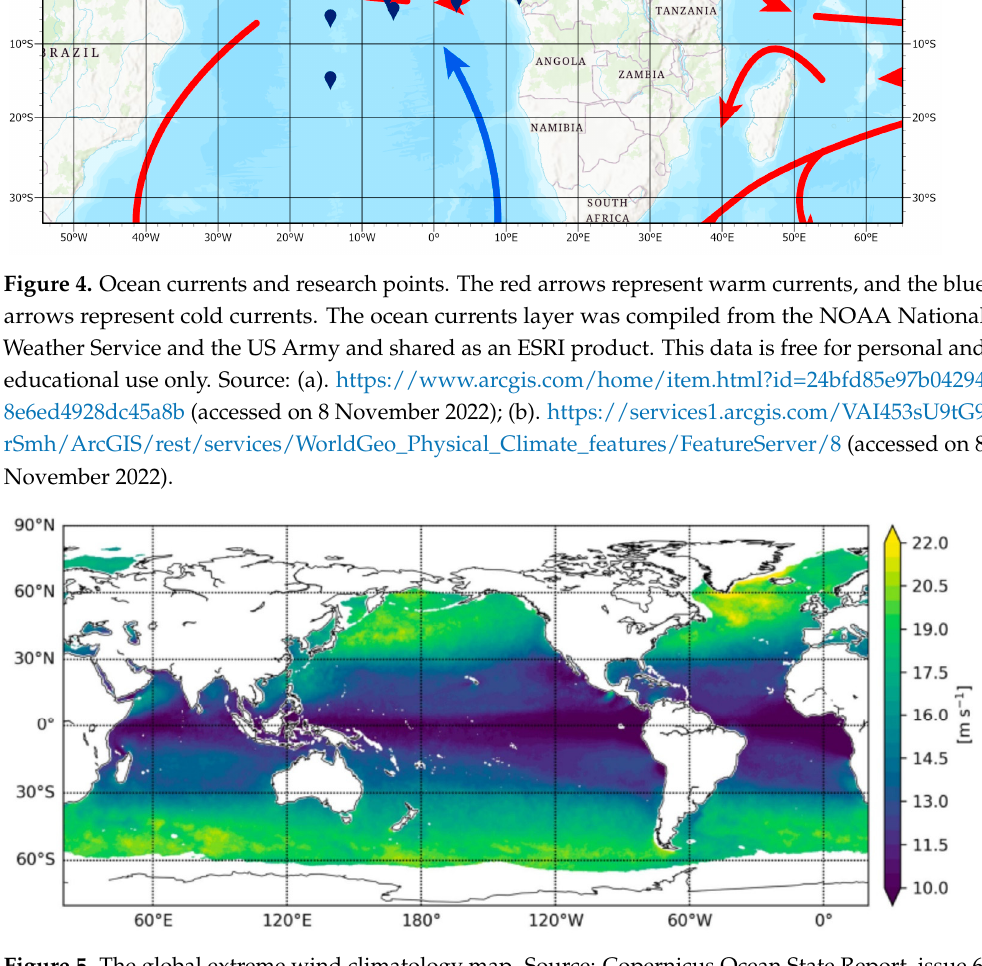
Figure 5. The global extreme wind climatology map. Source: Copernicus Ocean State Report, issue 6, Journal of Operational Oceanography (2022).